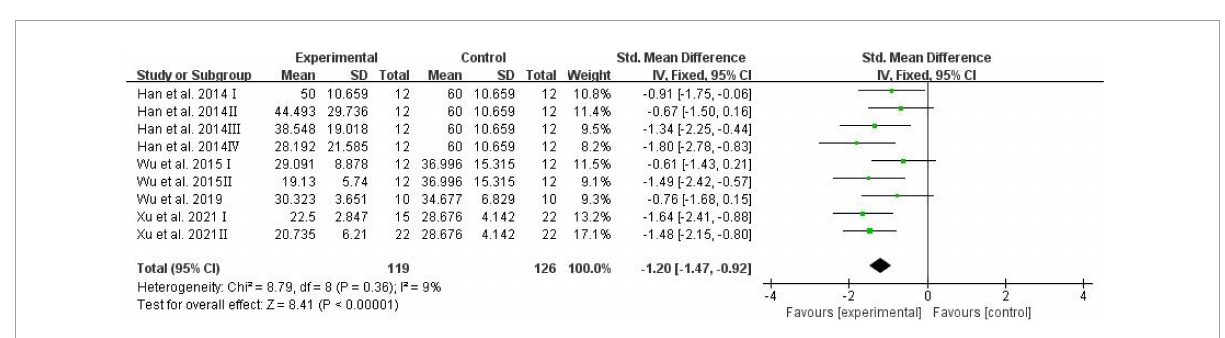
FIGURE2 Forest plot of the number of platforms crossing in the Morris water maze test.